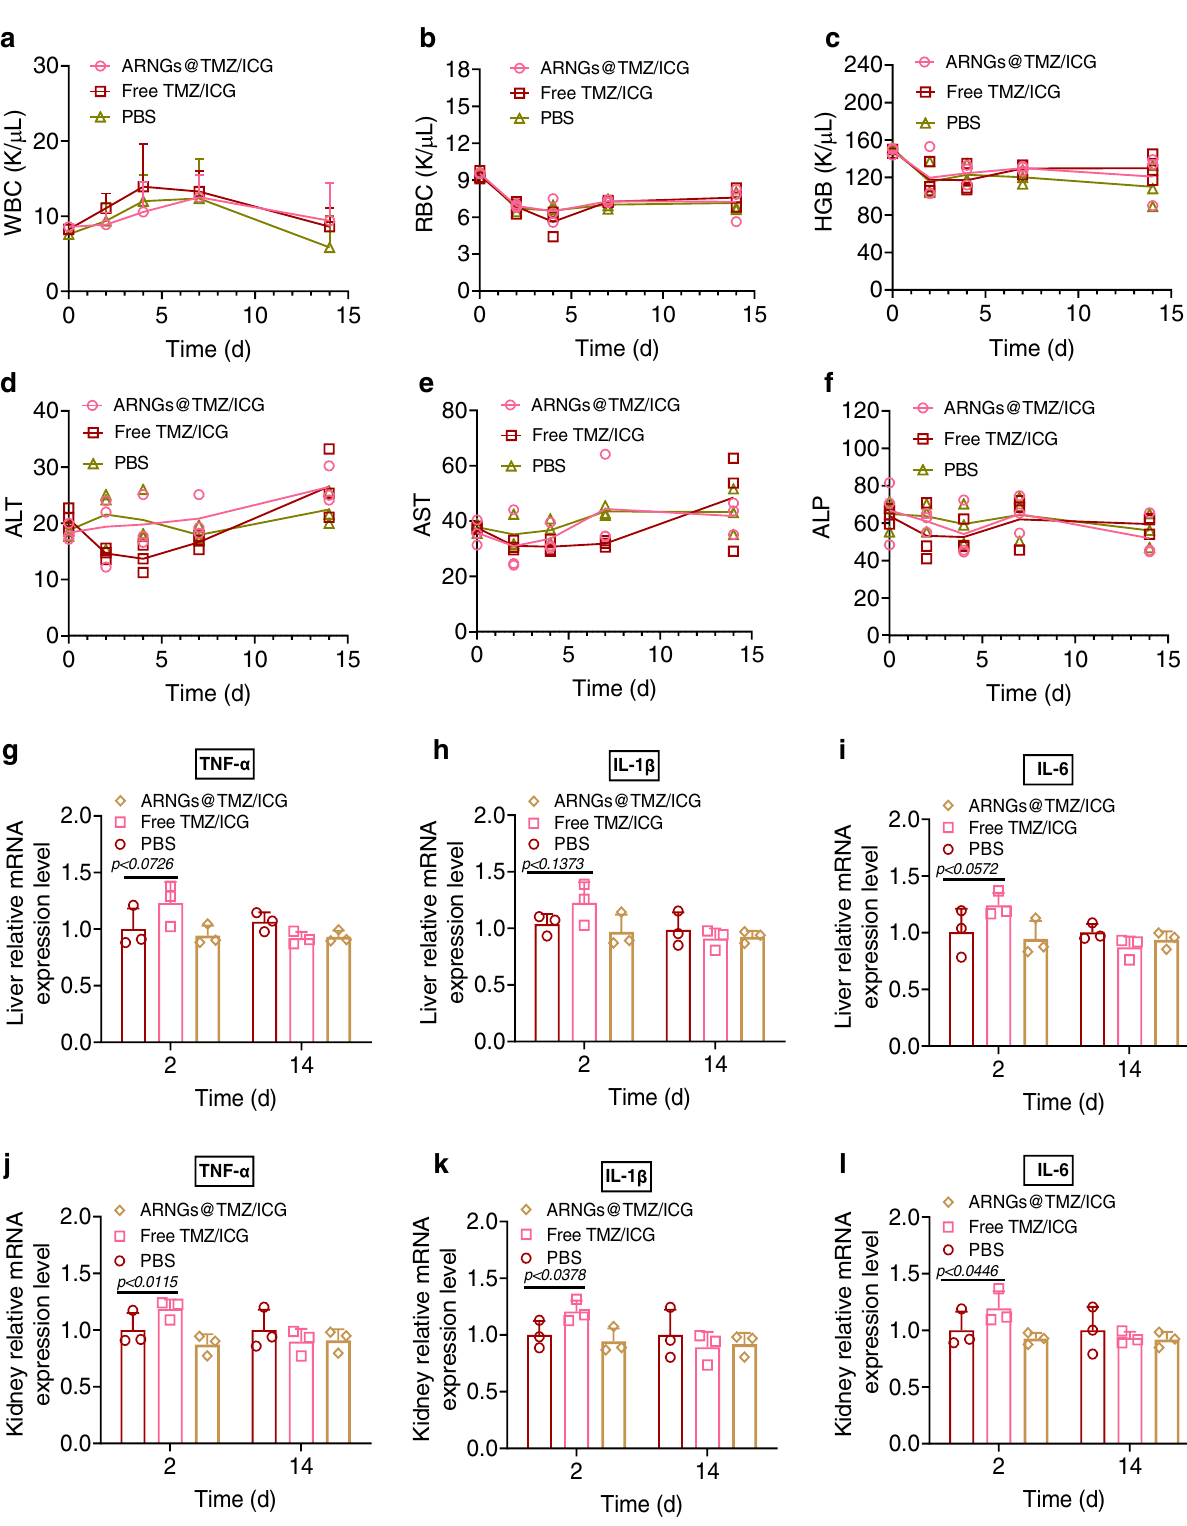
aminotransferase (AST) ( f ) levels were assessed after a single dose tail vein injec- tion. Data are presentedasmean±SD. g – l Expression of sentinel proin fl ammatory cytokinesTNF- α ,Il-1 β andIl-6inliver( g – i )andkidney( j – l )assessedonDay2and14 after a single dose tail vein injection. Data are presented as mean±SD ( n =4 independent samples, one-way ANOVA and Tukey multiple comparisons